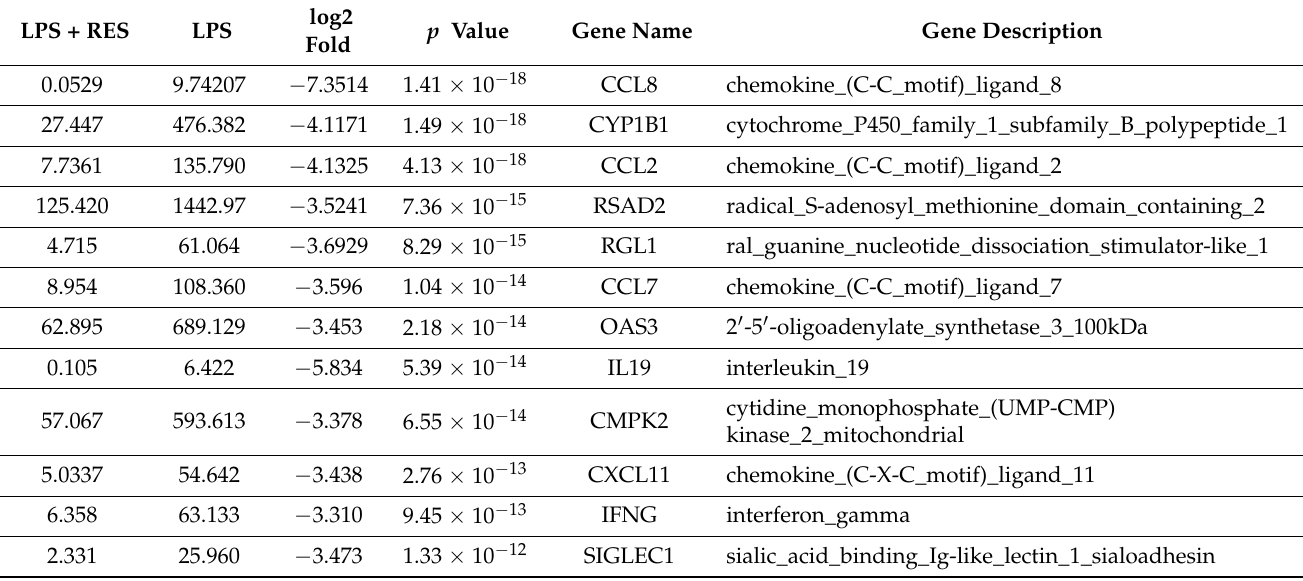
Table 2. LPS-induced genes downregulated by resveratrol (RES)